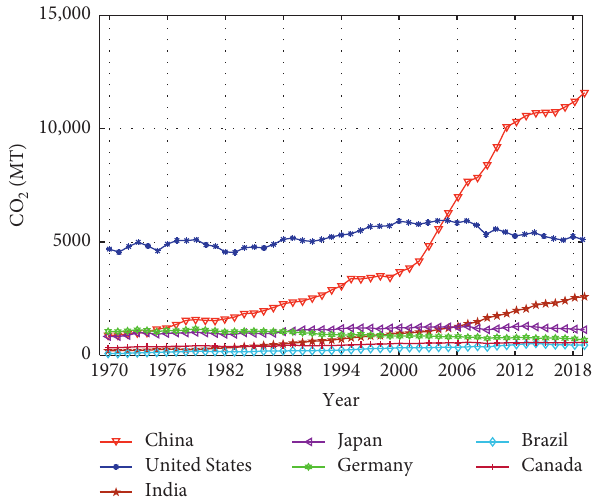
Figure 1: Comparison of annual CO 2 emissions by country (the CO 2 emission data of 6 countries comes from the Emissions Database for Global Atmospheric Research (EDGAR): https://